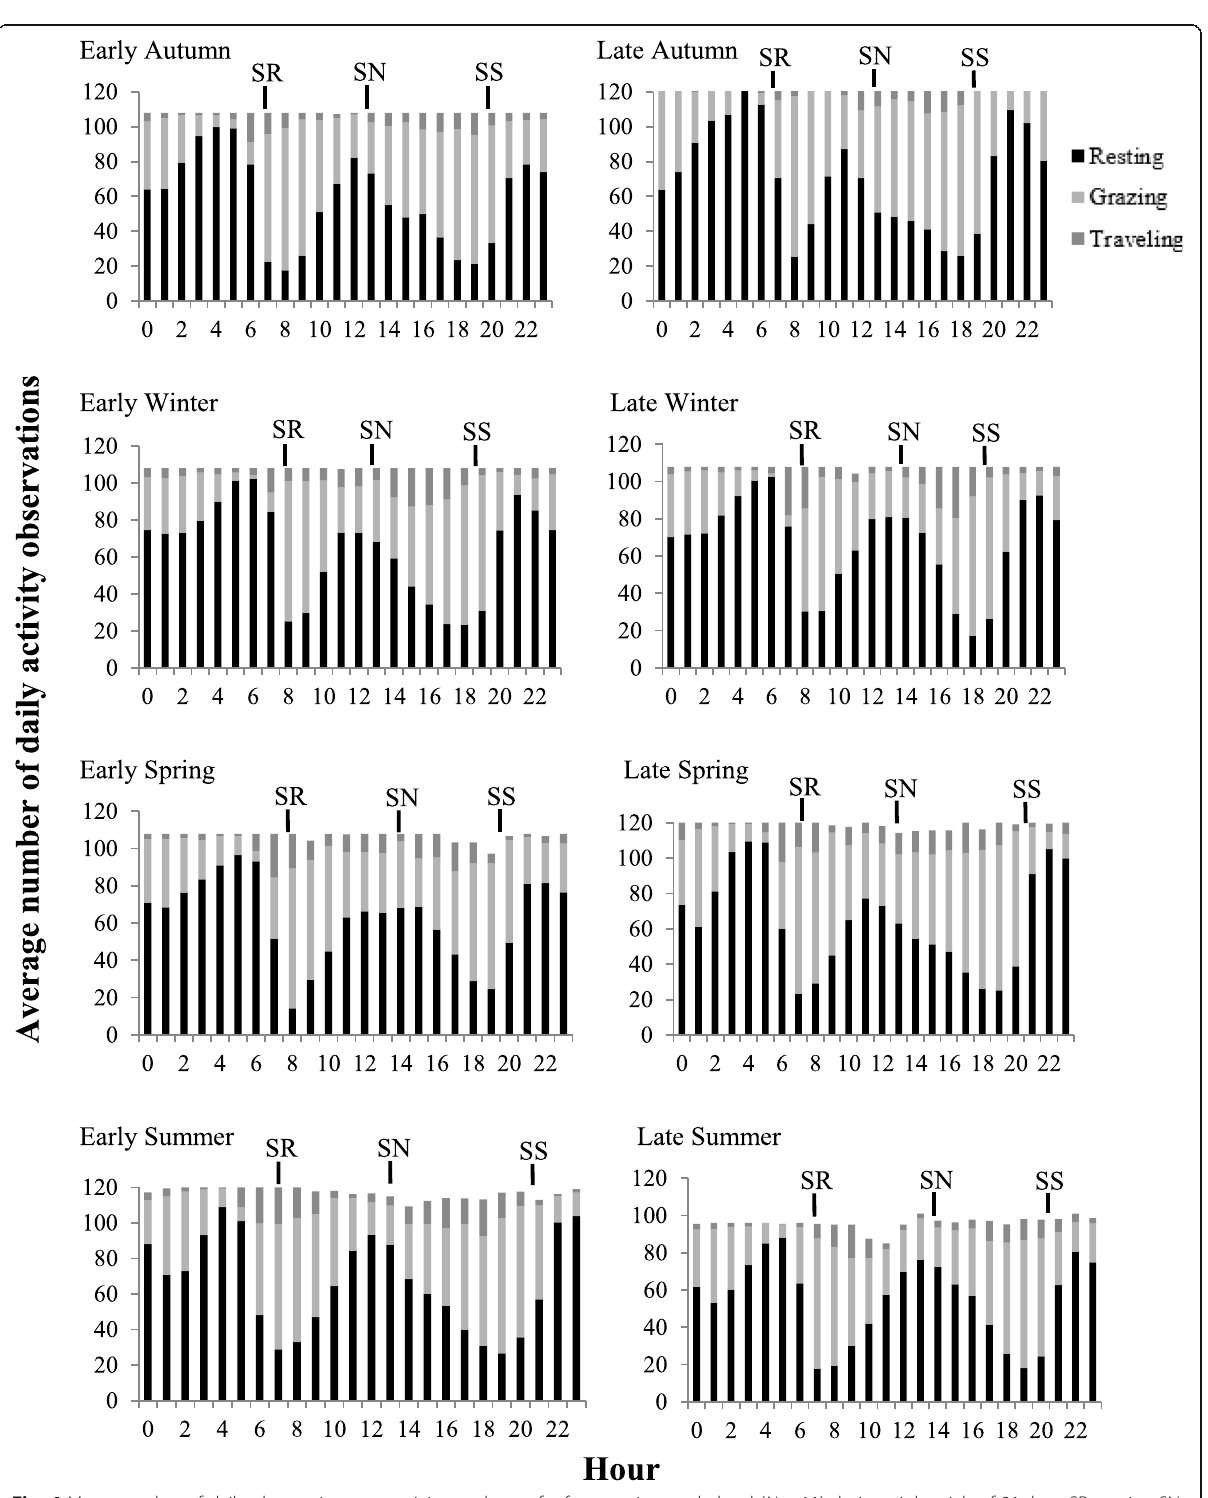
Fig. 4 Mean number of daily observations per activity per hour of a free-ranging cattle herd ( N = 11) during eight trials of 21 days. SR sunrise, SN solar noon, and SS